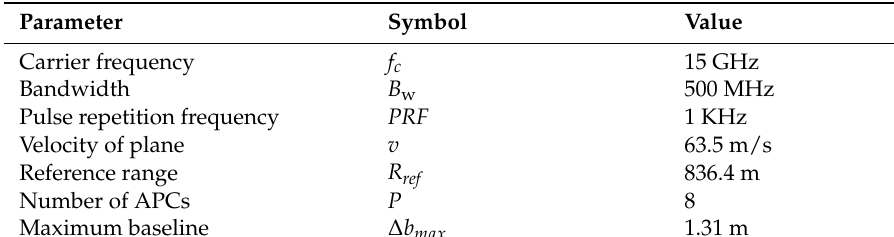
Table 1. Array ISAR system configuration.